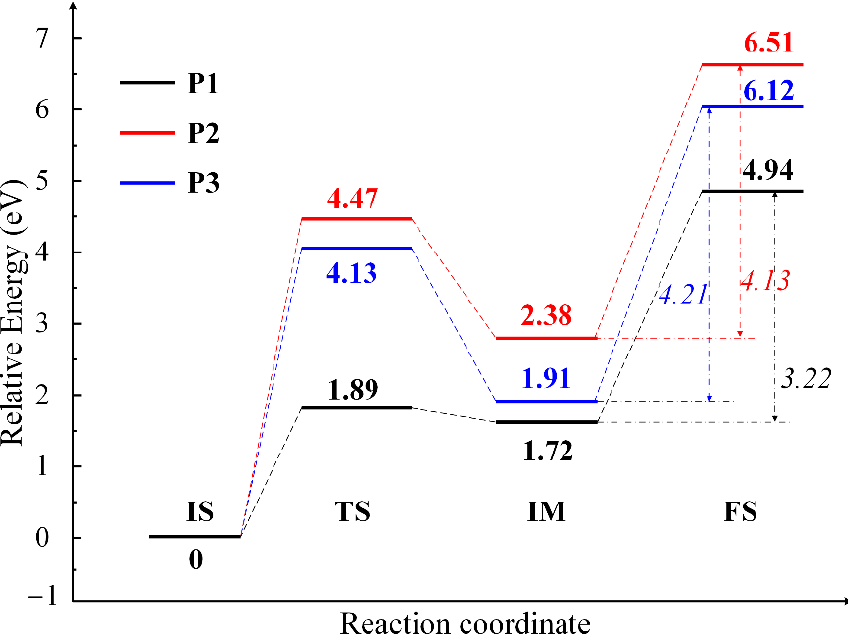
Figure 2. Potential energy diagram for the O 2 formation and desorption processes following different pathways on the CuO(110) surface of O-terminated.